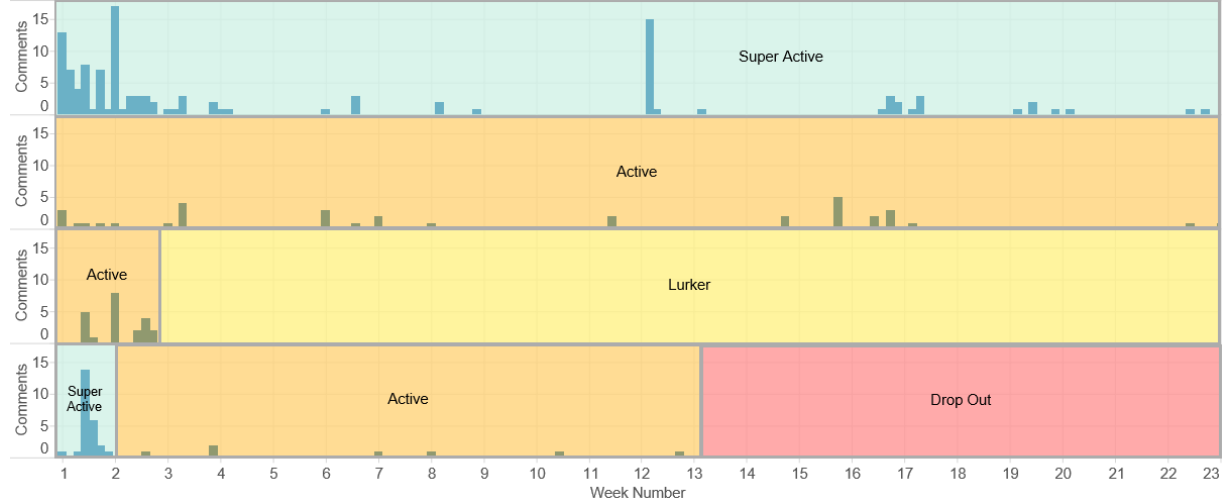
Figure 7. Commenttimesthroughoutthe study withfourexamplesof levels of engagements.